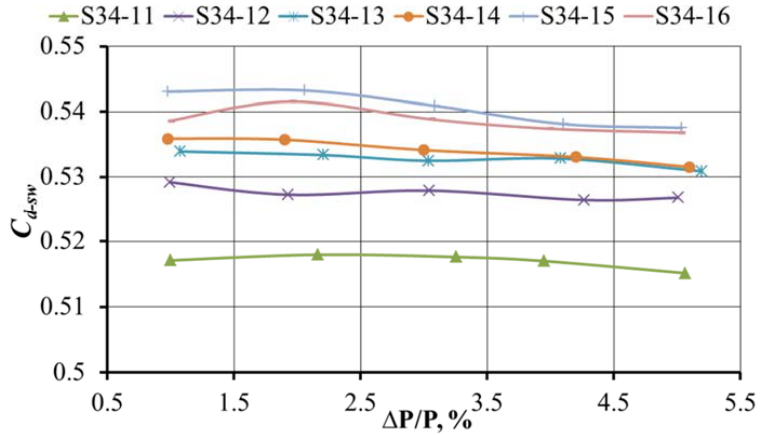
Figure 7. The effect of vane number on discharge coefficient.